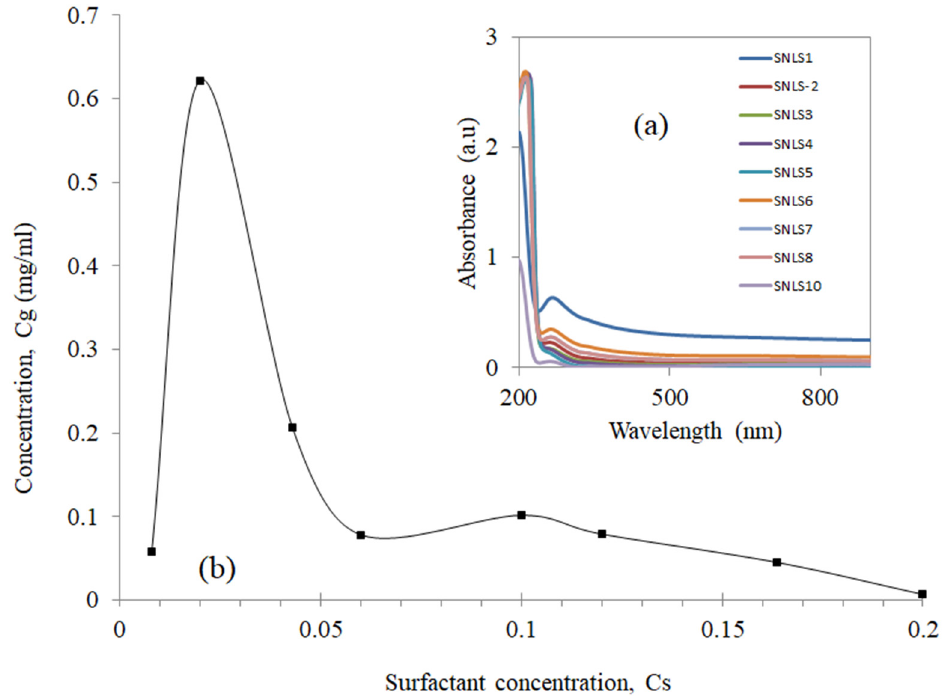
Figure 3. ( a ) UV-vis absorption spectra for different surfactant concentrations. ( b ) Variation in the concentration of graphene, Cg with the surfactant concentration, Cs graph with centrifugation frequency of 1500 rpm for half an hour, followed by another centrifugation with a frequency of 3000 rpm for another half an hour, 0.2 mL graphene dispersion was mixed with 5 mL water.